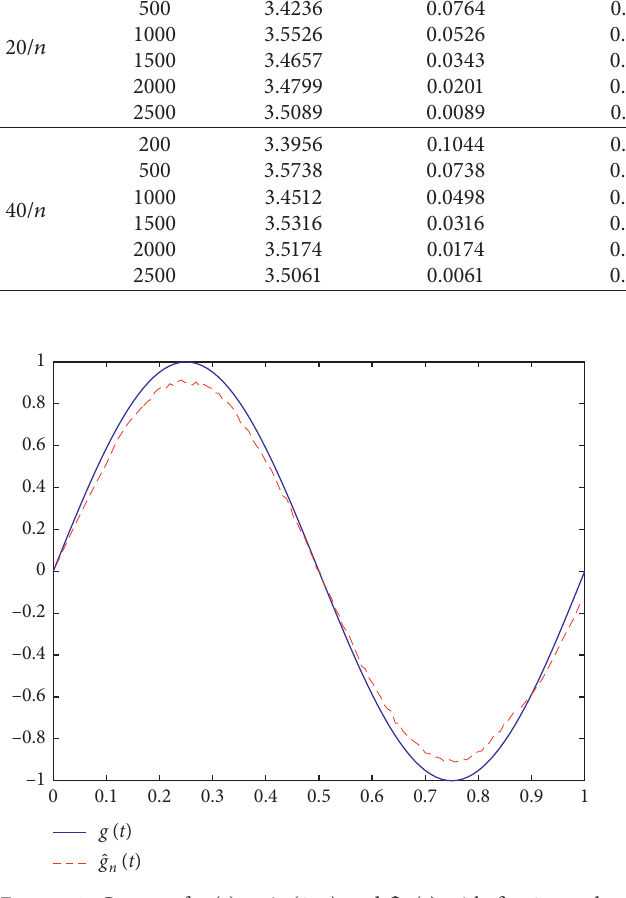
( t ) with β � 3 . 5 and n